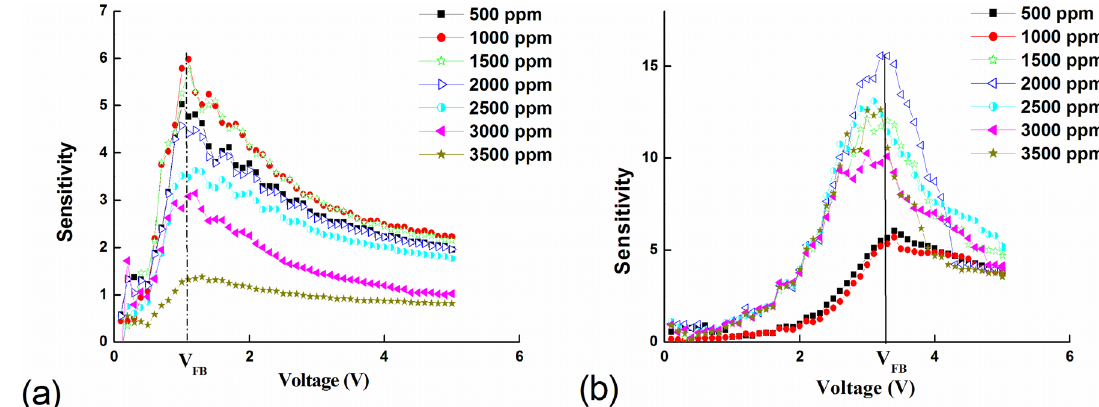
Figure 6. Sensitivity as a function of applied bias for Pd MSM device structures based on ( a ) Pd-doped and ( b ) Pd microstructure embedded active layers. The LPG concentration is varied from 500 to 3,500